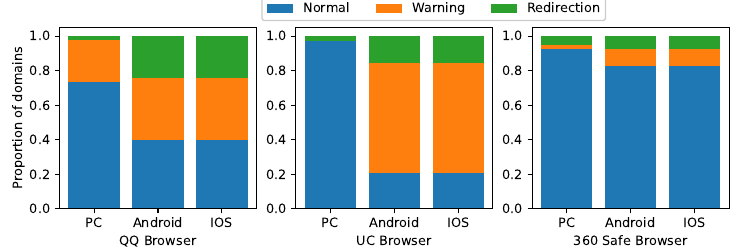
Figure 9. The results of each browser handling the reported abusive